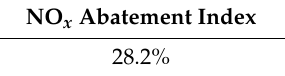
Table 3. NO x abatement index according to Standard UNI 11247 [20].